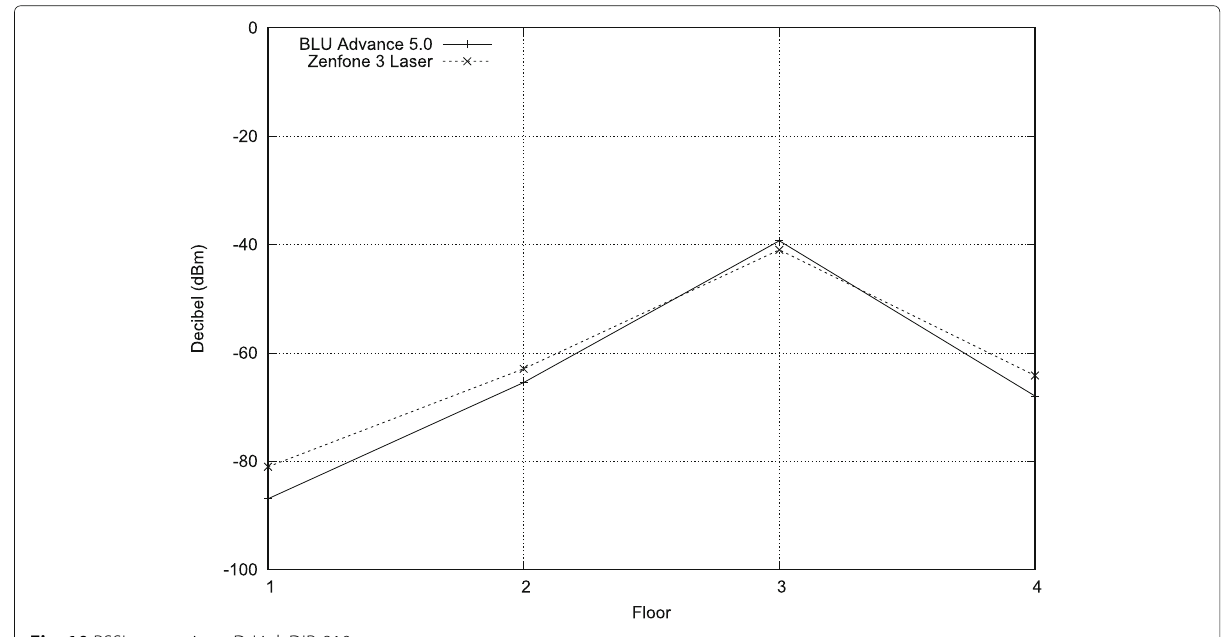
first experiment, the smart phones are placed side-by- side on the first floor. Then they start to collect the RSSI readings from the routers mentioned previously. After receiving 200 readings from each of the routers, the aver- age of the 200 readings is used as the final RSSI value. In the second, third, and fourth experiments, the smart